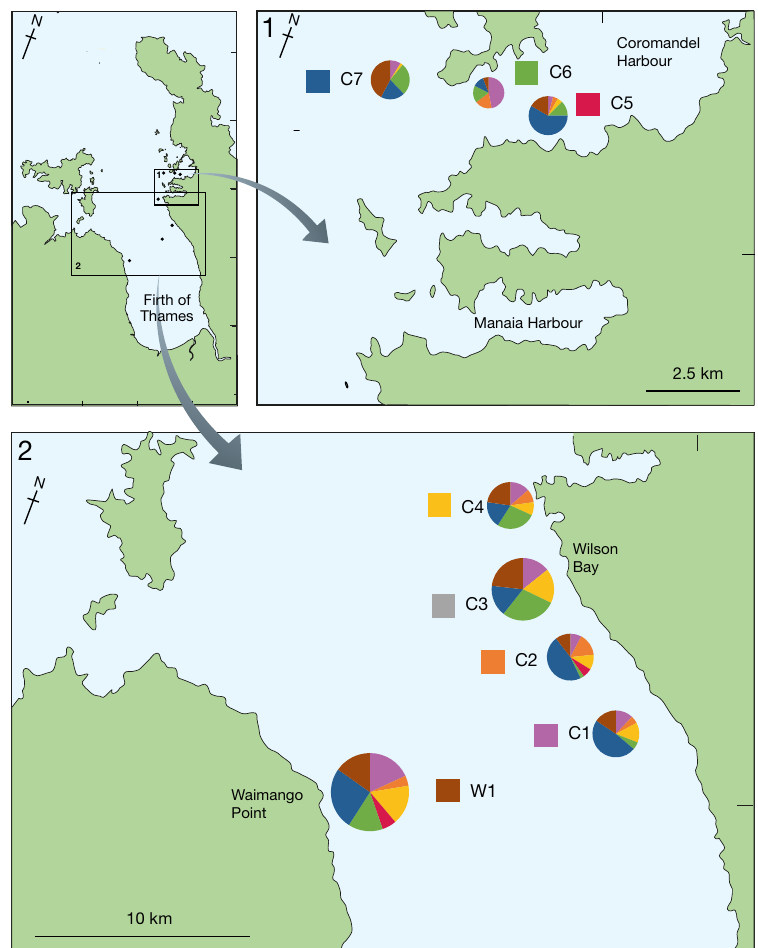
Fig. 7. Proportional natal locations of Perna canaliculus settling at monitored locations throughout the Firth of Thames as predicted by the quadratic dis- criminant function analysis trained using shell material deposited in situ at these locations. Coloured square adjacent to the site names (W1−C7): colour codes of settlers originating from these sites. Note the size of circle indicates the number of settlers at each site standardised per day (Table